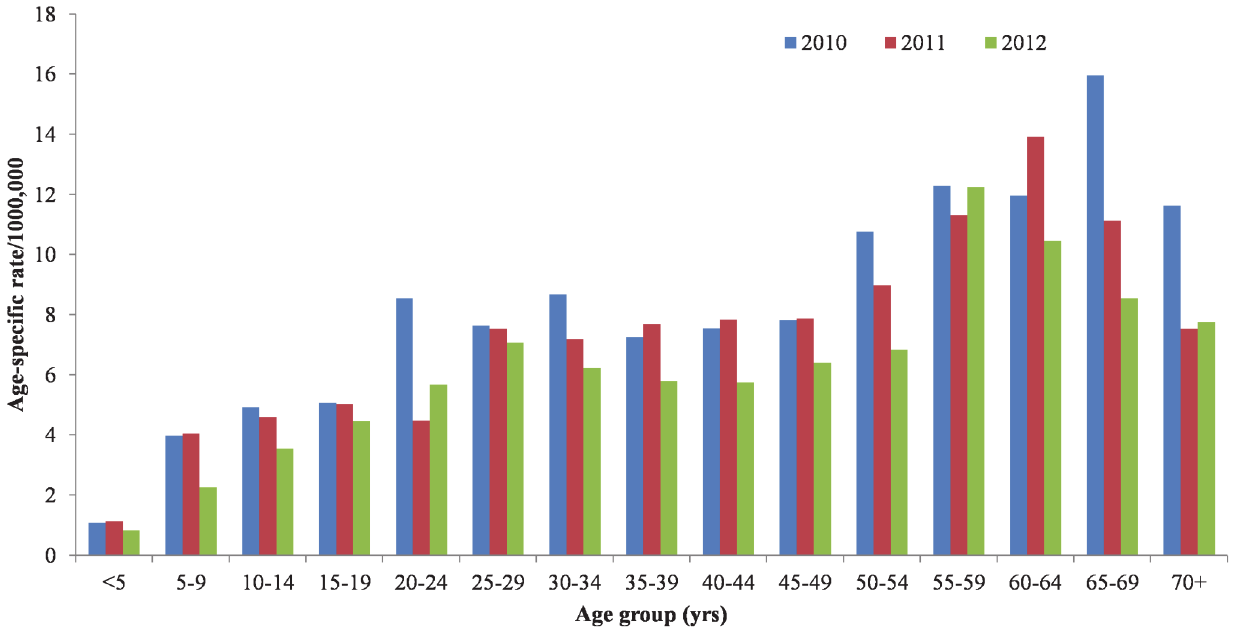
Fig 3. Age-specific dengue fever incidence rates, Taiwan, 2010 – 2012.